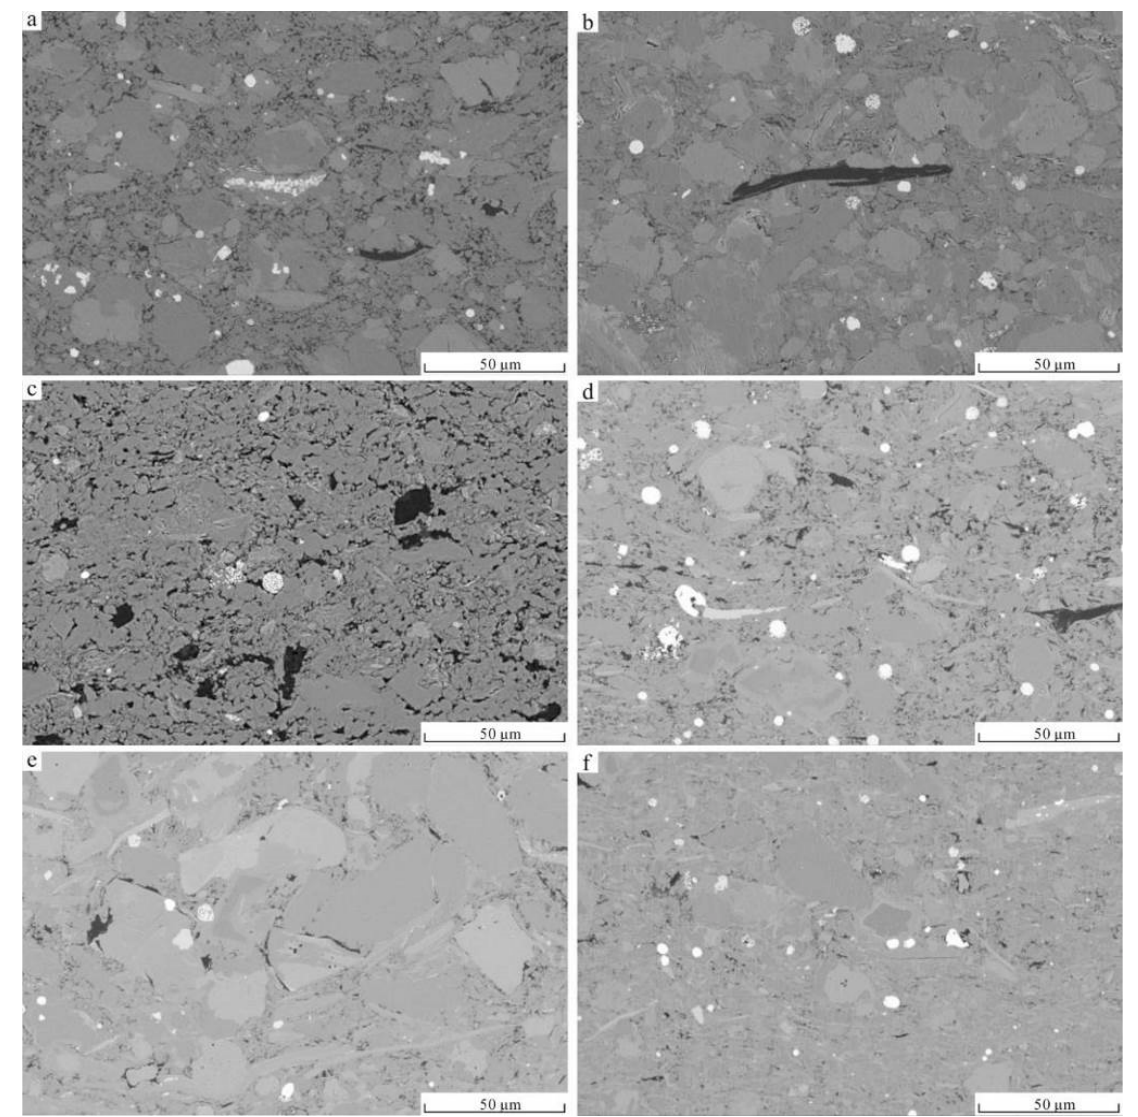
Figure 9. SEM photos showing typical minerals and grain sizes of various intervals of the Wufeng– Longmaxi shale on the Yangtze Platform, South China. ( a ) Sample from the Wufeng Formation of well N211, mainly composed of quartz, calcite, dolomite, and clay minerals with grain sizes ranging from 22 to 45 µ m; ( b ) sample from the Guanyingqiao bed of well N211, mainly composed of calcite and dolomite with small amounts of quartz with grain sizes ranging from 20 to 40 µ m; ( c ) sample from LM1 of well Z201, mainly composed of quartz with grain sizes less than 4 µ m; ( d ) sample from LM2–3 of well YH3–8, mainly composed of quartz with small amounts of calcite and dolomite; ( e ) sample from LM4–5 of well YH3–8, mainly composed of quartz, calcite, and dolomite with small amounts of clay minerals; ( f ) sample from LM6 of well YH3–8, mainly composed of quartz, calcite, and dolomite with small amounts of clay minerals.